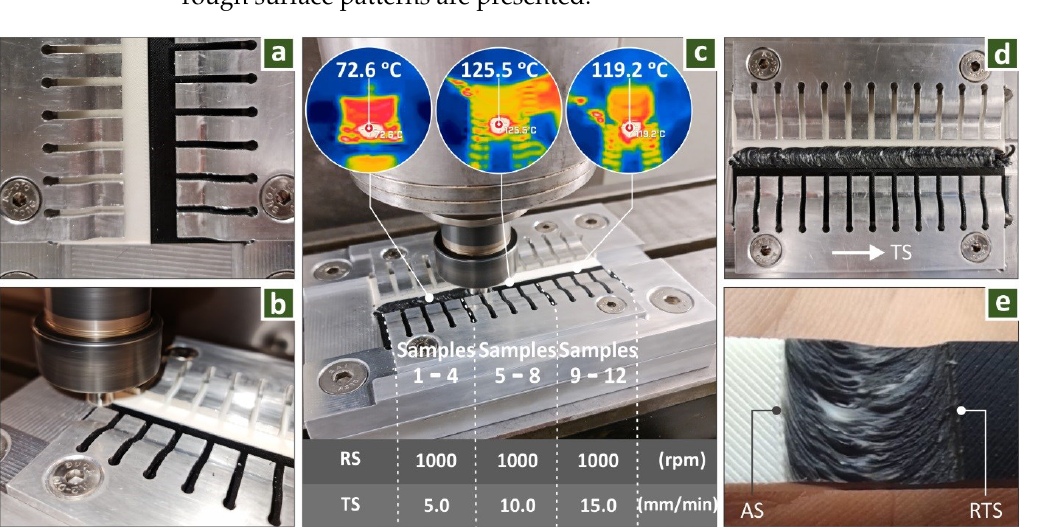
Figure 4. ( a ) ABS workpieces with two different colors for the proof-of-concept experiment, fixed in the fixture, ( b ) proof of concept experiment, ( c ) conditions for the FSW experiment, and monitoring of the temperatures during the FSW experiment, ( d ) weld seam produced during the calibration of the process, and ( e ) detail of the weld seam.